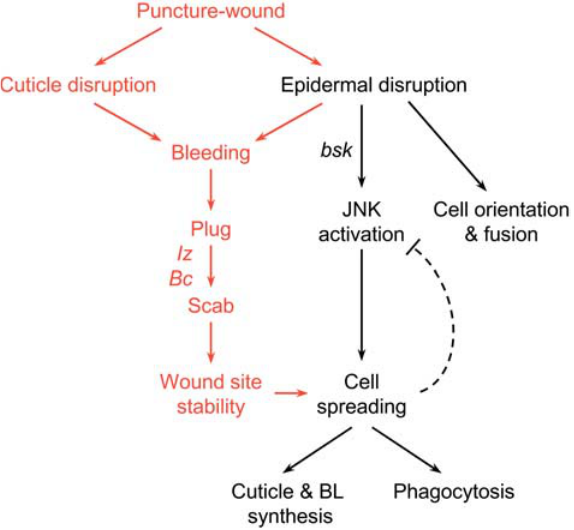
Figure 8. Model of the Cellular Events and Genetic Requirements of Larval Wound Healing Puncture wounding disrupts the epidermis and overlying cuticle and triggers the three parallel series of events shown, each with distinct genetic requirements. Plug and scab formation stabilize the wound site, which promotes epidermal cell spreading and suppresses JNK activation, perhaps by a negative feedback mechanism (dashed line). The lz and Bc genes promote scab formation, presumably by promoting crystal cell development and the production and secretion of serum melanization factors by these cells. The spreading epidermal cells synthesize cuticle and basal lamina, and they clear wound site debris by phagocytosis. Pinch wounding disrupts the epidermis but not the overlying cuticle and triggers only the events shown in black. However, cuticle and basal lamina synthesis and phagocytosis have not been examined in pinch wounds and are only inferred to occur from the puncture wound studies. Wounding may induce additional signals (not indicated) that attract blood cells (plasmatocytes) and tracheal